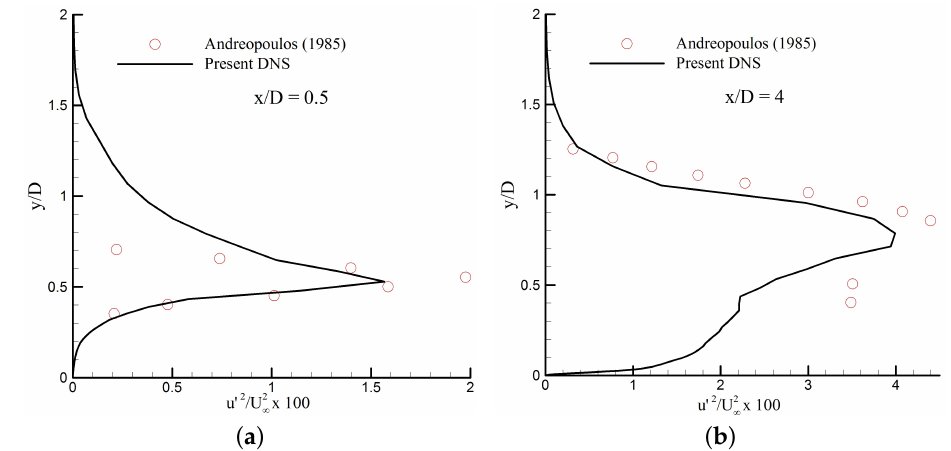
Figure A2. Profiles of streamwise Reynolds normal stresses for x / D : ( a ) 0.5, ( b )